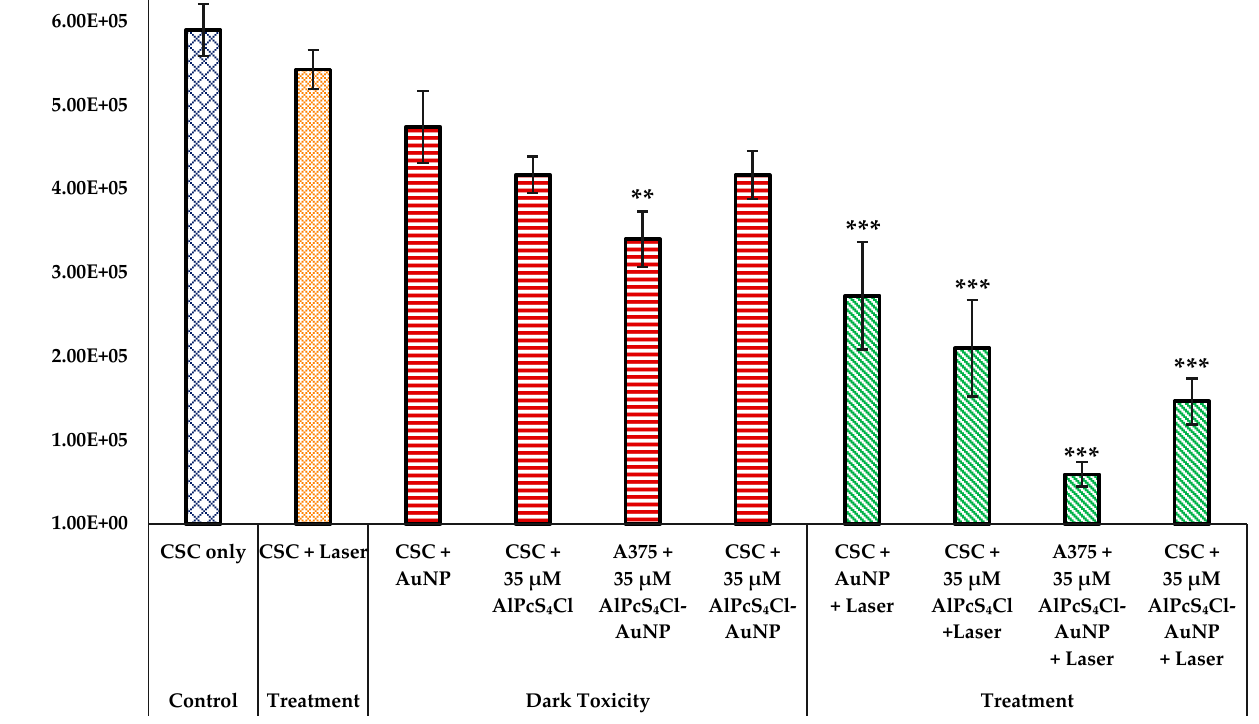
Figure 8. Proliferation of A375 CSCs after laser irradiation measured as a luminescent value in RLUs for control, dark-toxicity, and treatment cell groups with laser irradiation at 673 nm, radiant exposure: 5 J/cm 2 (significance denoted as ** p < 0.01, and *** p < 0.001). The laser treatment group has shown significant reduction in ATP proliferation when treated with PS-AuNP conjugate in both A375 and CSC populations.